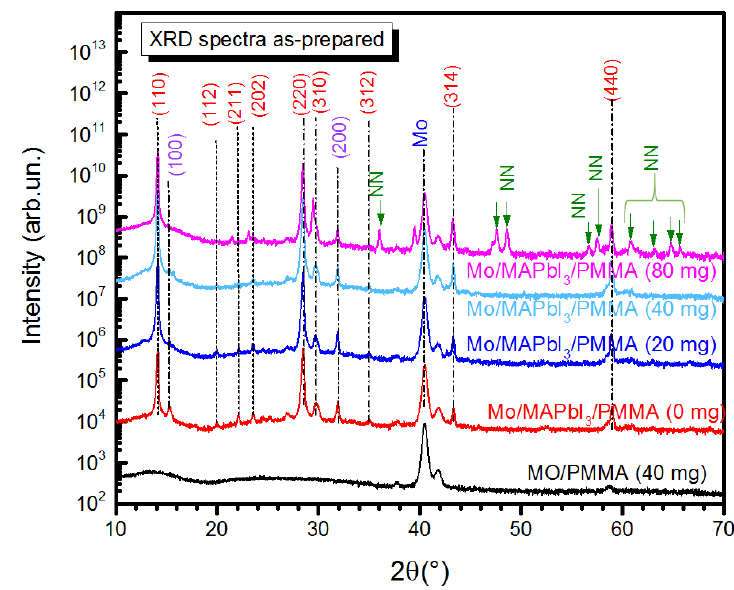
Figure 3. Grazing incidence X-ray diffraction patterns of Mo substrate coated with 40 mg/mL of PMMA (black); and of Mo/perovskite coated with PMMA at concentrations of 0, 20, 40, and 80 mg/mL (red, blue, dark cyan, and magenta, respectively) for the as-prepared sample.